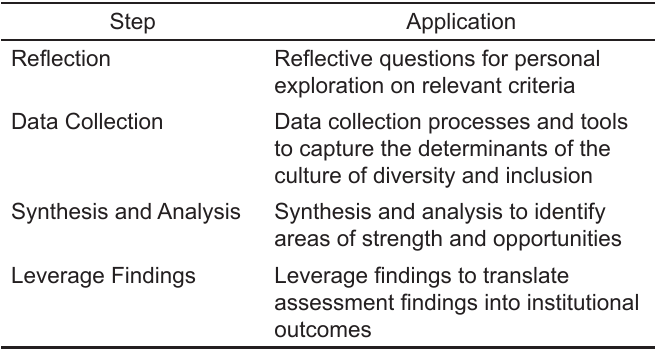
Table 2. Key steps to assessing culture and climate